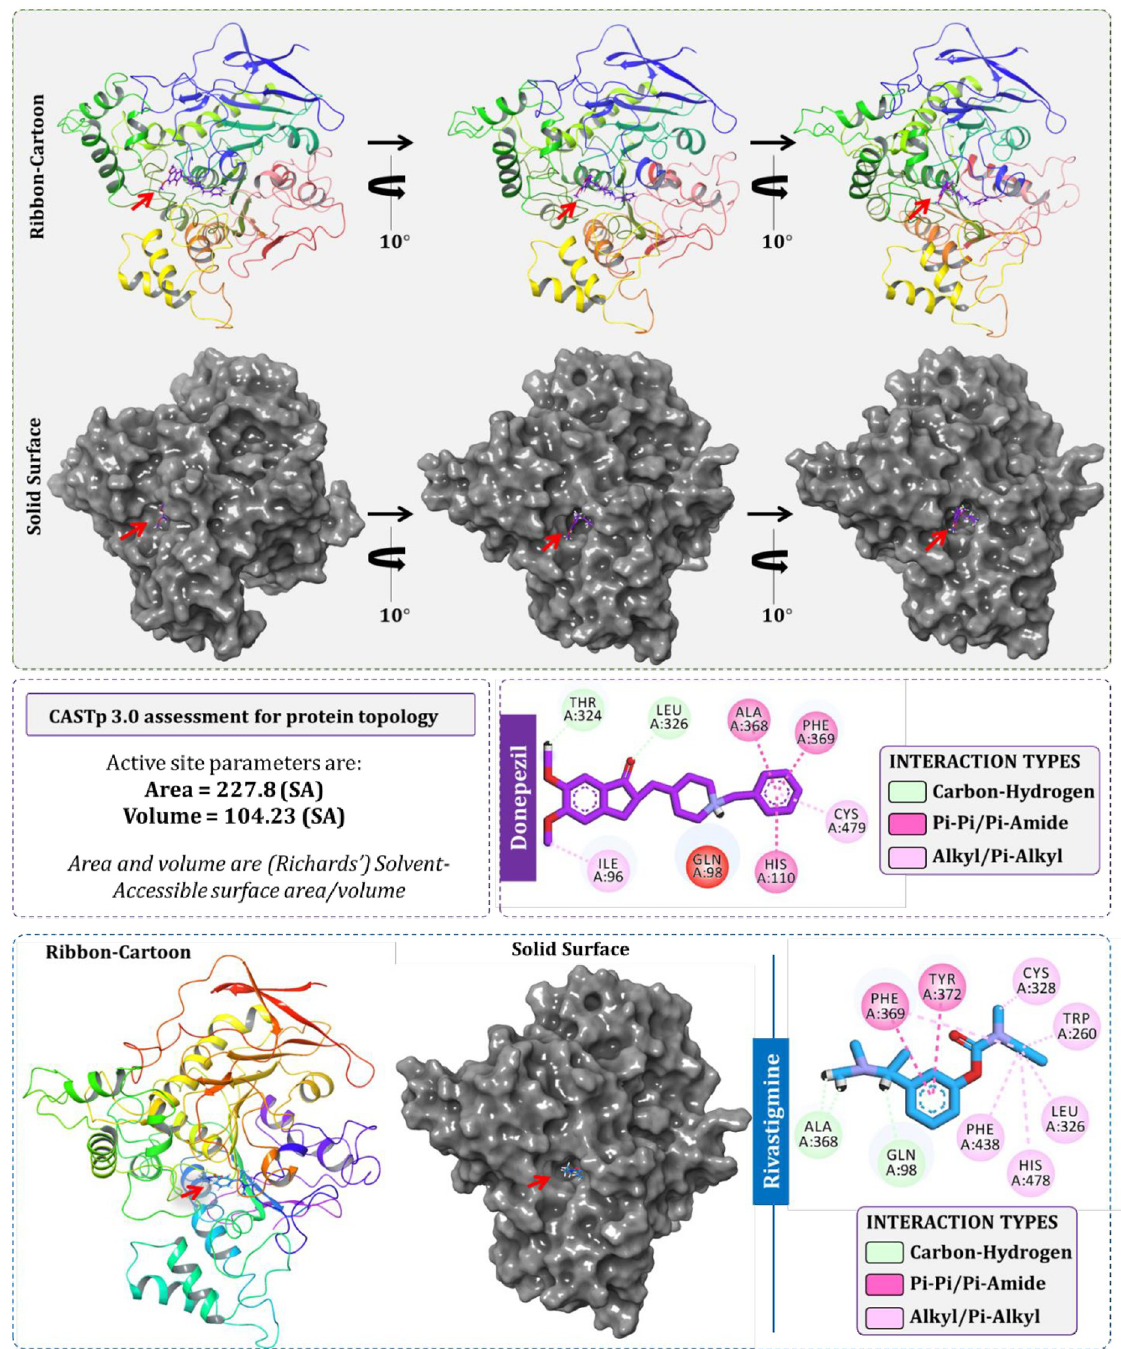
Fig 4. Molecular docking of donepezil and rivastigmine with modelled BChE at the identified active site with the help of CASTp 3.0. desmethoxycurcumin had better Δ GBind than rivastigmine but inferior to donepezil. Thus, based on docking and MM-GBSA assessment, curcumin was a lead phytochemical identified. Like control drugs, curcumin was effectively able to interact with BChE by making hydropho- bic interactions involving amino acids residues Gly145, Phe369, Tyr372 (Pi-Pi interactions);